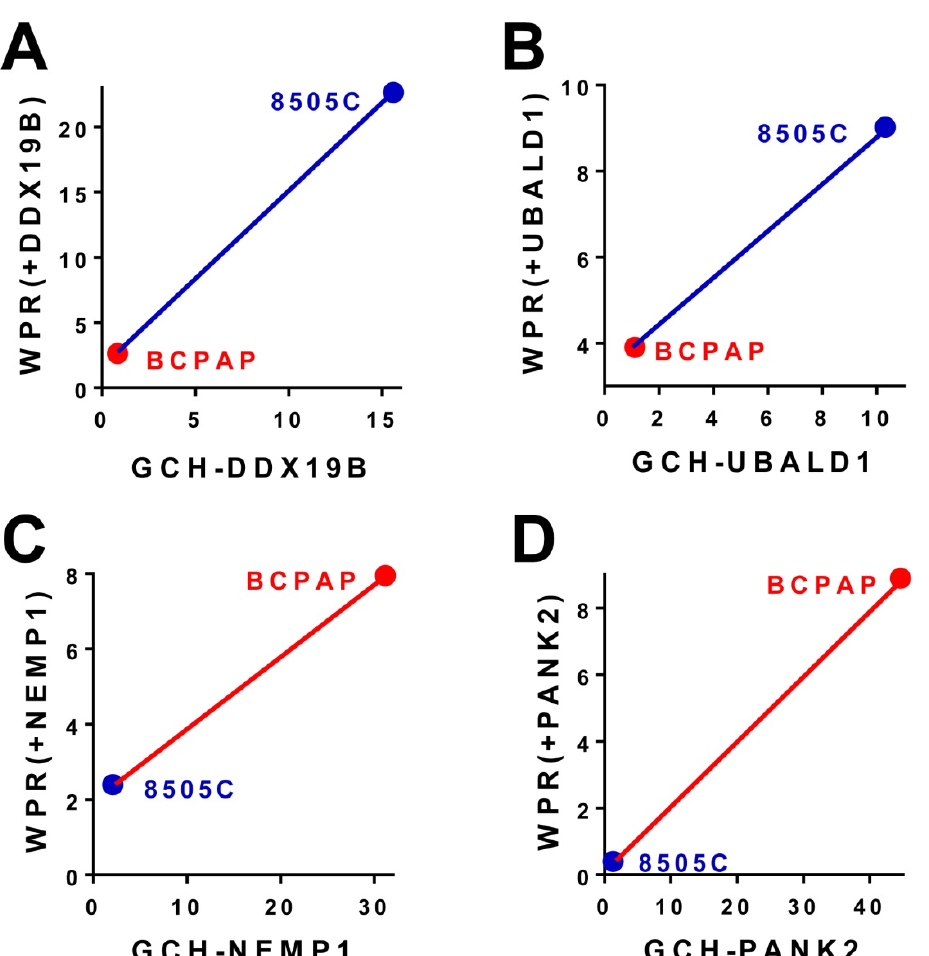
Figure 3. Data from GSE97031, GSE97028, GSE97030, GSE97427, [22]: Validation of the GMR Theory. ( A , B ). Stable transfection of genes with higher GCH in the 8505C cells than in BCAP cells had larger transcriptomic effects in 8505C cells as measured by the Weighted Pathway Regulation (WPR). ( C , D ). Stable transfection of genes with higher GCH in the BCPAP cells than in 8505C cells had larger transcriptomic effects in BCPAP cells as measured by the Weighted Pathway Regulation (WPR).